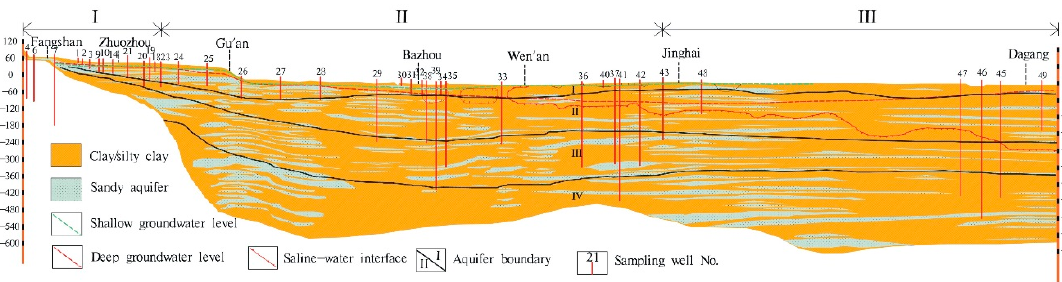
Figure 2. Schematic hydrogeological cross-section of the sampled path. Investigated wells and their depths are indicated by vertical numbered lines (e.g., 21 represents No. 16-21). Boundaries of the aquifers I~IV at different depths are shown using black solid lines.